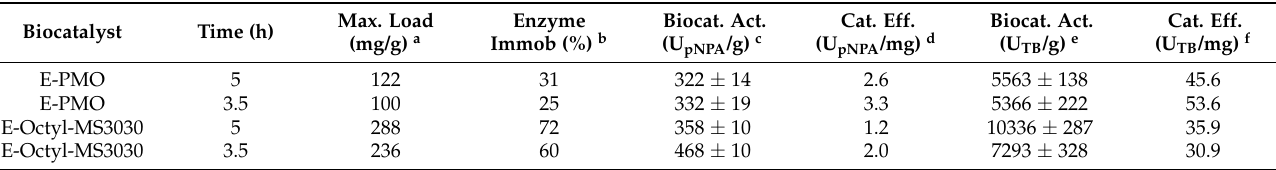
Table 1. Results obtained in the enzymatic activity in the hydrolysis of p-nitrophenylacetate (pNPA) as well as in the hydrolysis of tributyrin (TB), thus obtaining the enzyme load of the investigated biocatalysts.